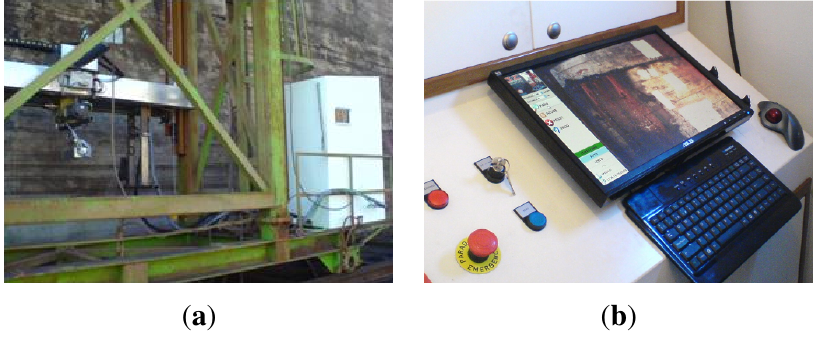
( b ) Detailed image of the Supervision Unit graphic interface installed inside the